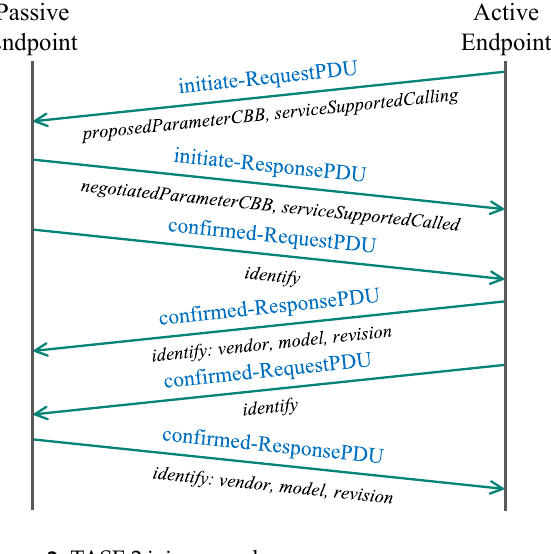
Figure 2. TASE.2 join procedure.